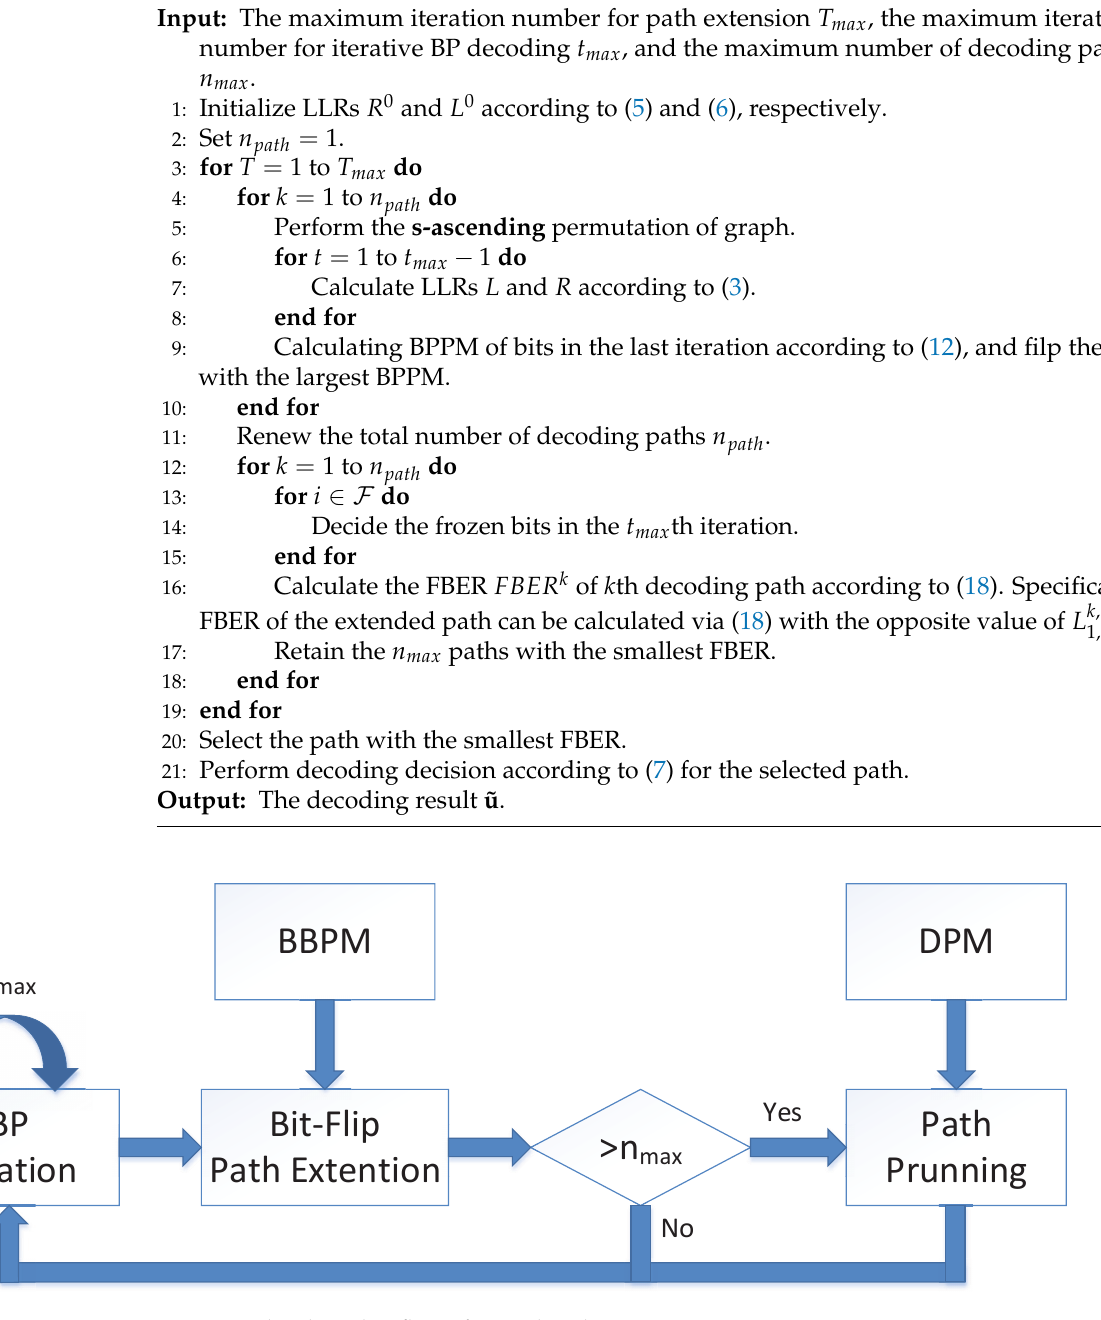
Figure 5. The algorithm flow of IBPL